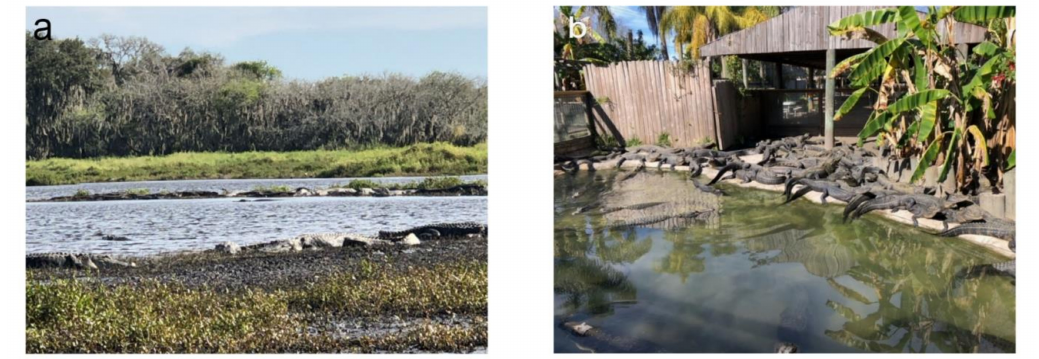
Figure 9. ( a ) The basking area of the wild site. ( b ) The basking area of the captive enclosure, showing the typical spacing of individual alligators during basking